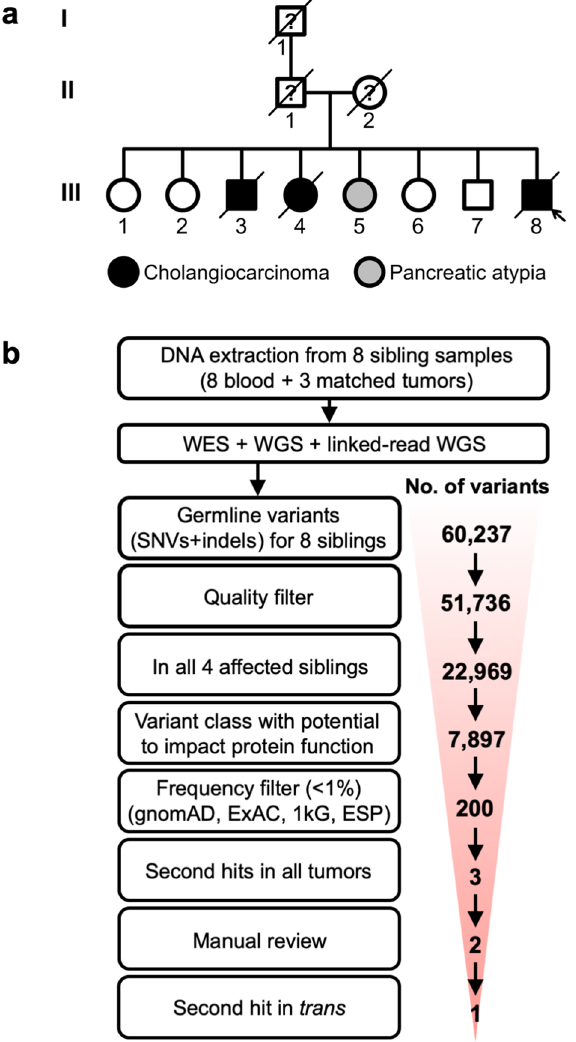
Figure 1. Identification of a putative germline predisposition variant in a family with inherited CCA. ( a ) This pedigree depicts a family with an inherited predisposition to biliary cancers. The current study had access to samples from generation III of the family. ( b ) The number of putative germline variants (single nucleotide variants and insertion-deletions) is indicated for each stage of